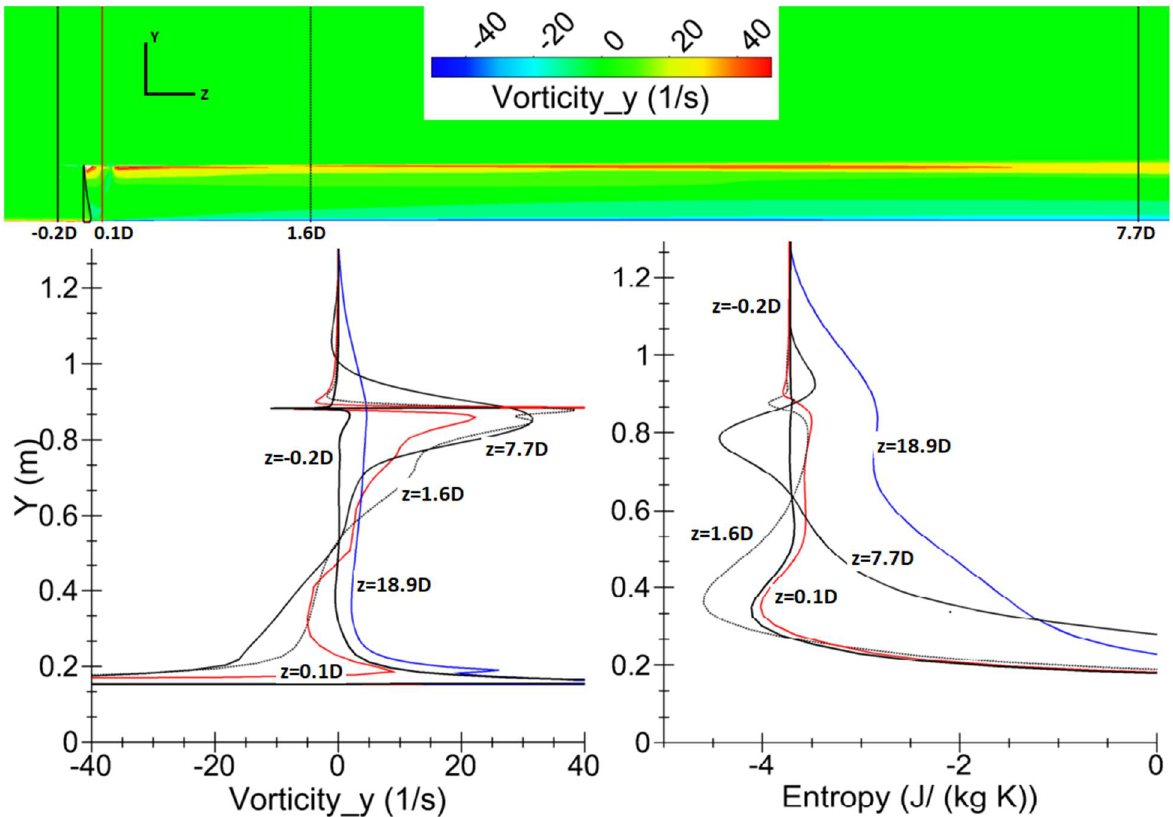
Figure 19. Vorticity_Y contour downstream of the rotor with spanwise plots of vorticity_Y and entropy for the solo propeller ( 3X-40R domain) 3D steady solution.